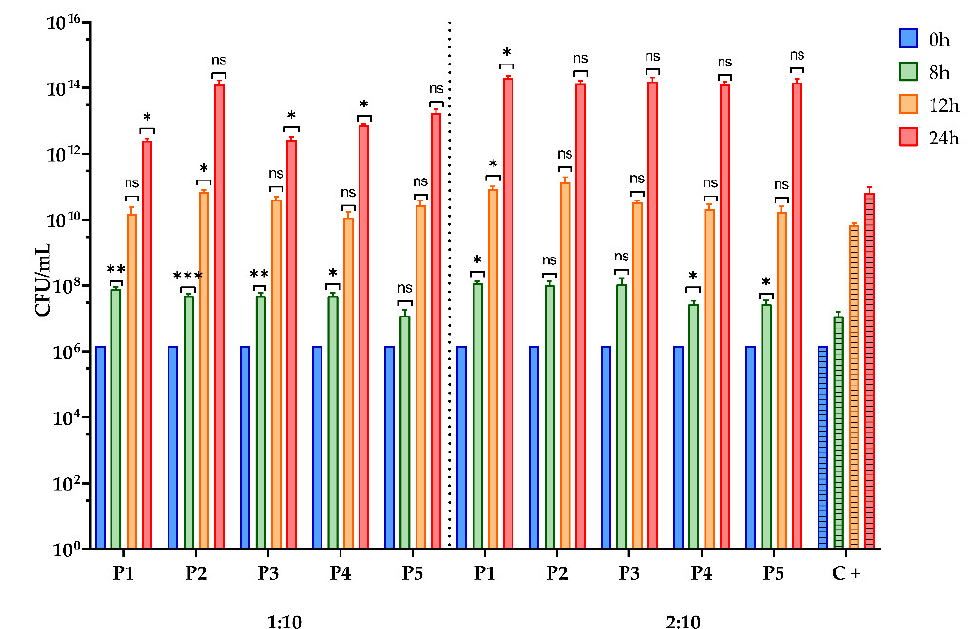
Figure 6. Graphic representation of CFU/mL values representing the influence of BPE on the bacterial growth of Enterococcus faecalis 2M17; (P1–P5)-BPE samples; (C+)- E. faecalis 2M17 growth control. The prebiotic effect of BPE on E. faecalis 2M17 growth was statistically analysed in one-way ANOVA and Dunnett’s multiple comparisons tests. The data is considered statistically significant. (ns—not significant; * p < 0.05; ** p < 0.08; *** p = 0.0009).